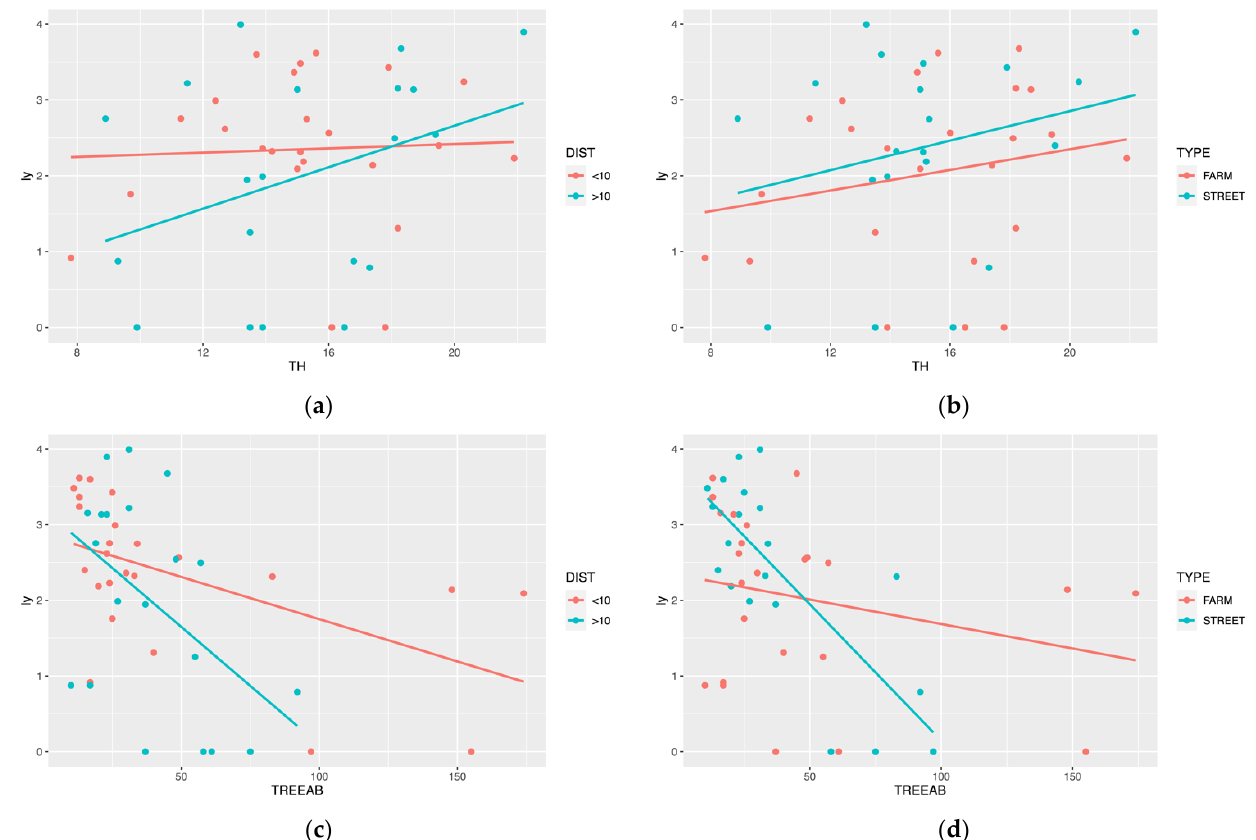
Figure 4. ALBs ’ population data were categorized according to sampling sites and fitted with TH and TREEAB separately; ( a , c ) showed the influence of the distance to the Beida River, ( b , d ) showed the influence of the forest type.